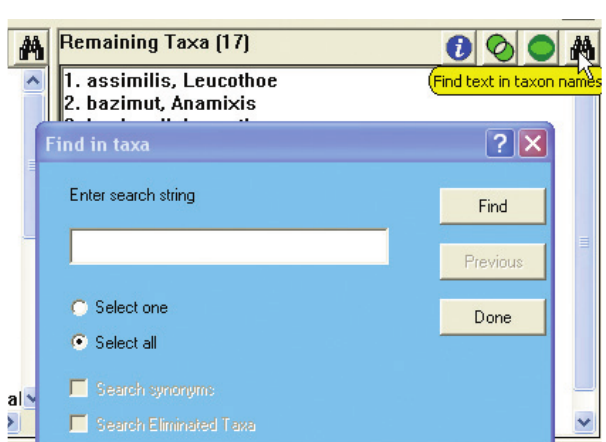
Figure 61. Find text in taxon names button.